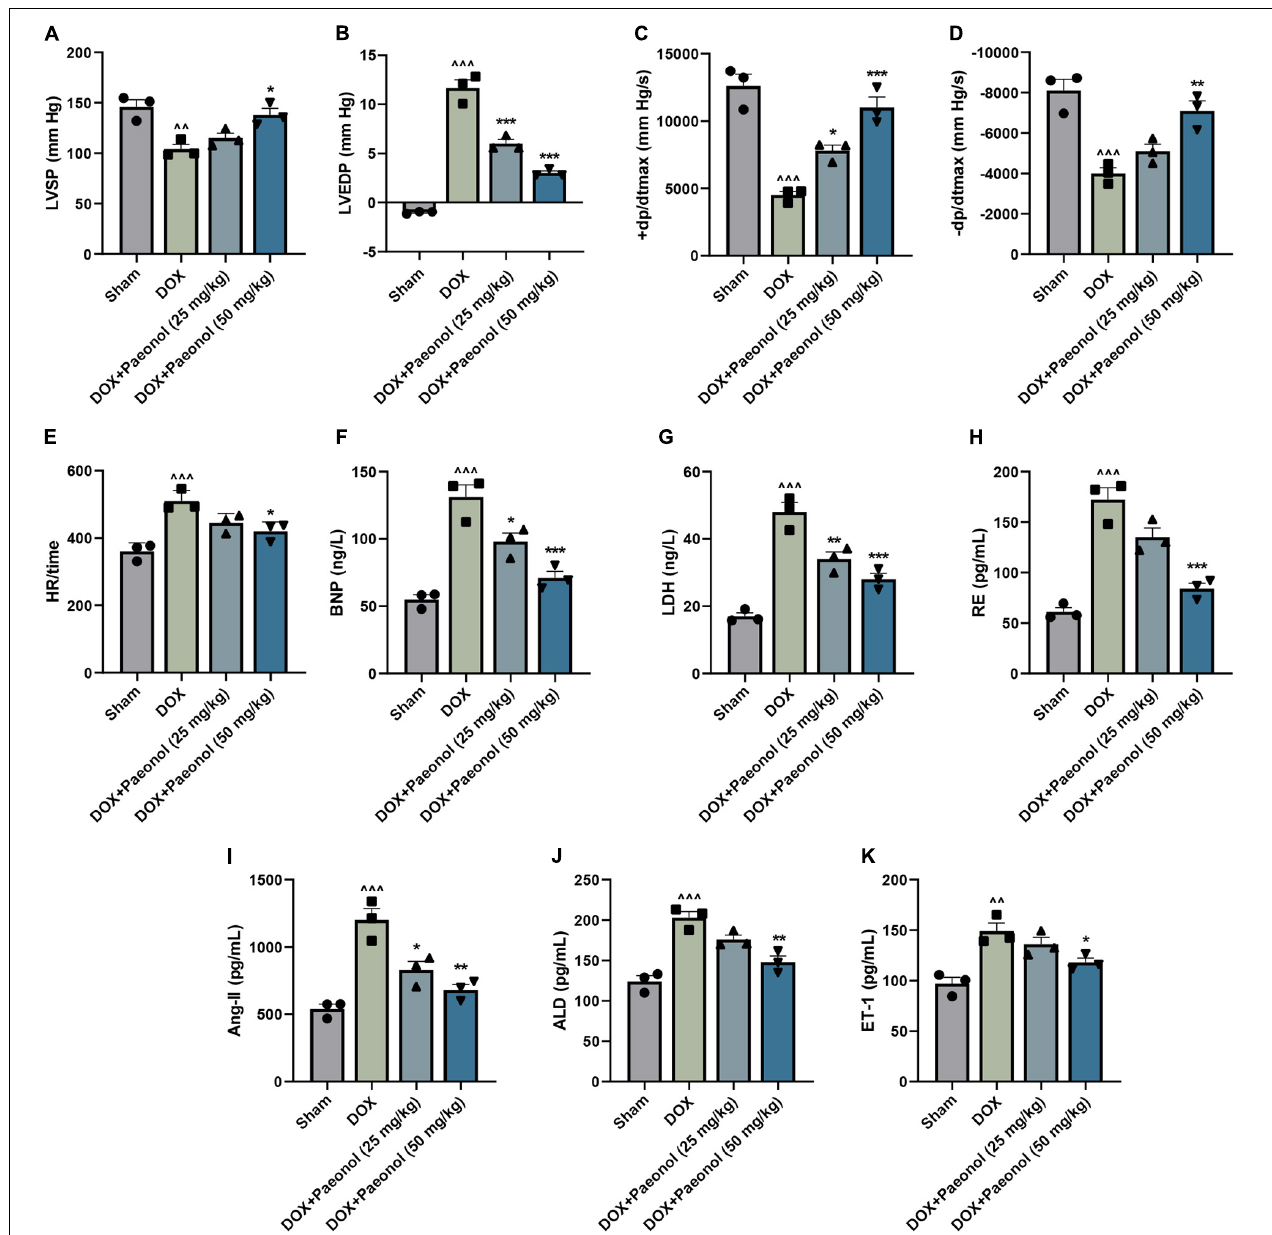
FIGURE 1 | Paeonol improved the cardiac function and ameliorated the cardiac damage of CHF rats. (A–E) The parameters underlying the cardiac function of the rats, including LVSP (A) , LVEDP (B) , +dp/dtmax (C) , –dp/dtmax (D) , and HR (E) , were detected using RM6240 series multichannel physiological signal acquisition apparatus. (F–K) The concentration of several specific markers related to the myocardial damage in the rats, including BNP (F) , LDH (G) , RE (H) , Ang II (I) , ALD (J) , and ET-1 (K) , were evaluated using a Synergy H1 Hybrid Multi-Mode Reader. ∧∧ P < 0.01, ∧∧∧ P < 0.001, vs. Sham; * P < 0.05, ** P < 0.01, *** P < 0.001, vs. DOX. DOX, doxorubicin; LVSP, left ventricular systolic pressure; LVEDP, left ventricle end diastolic pressure; +dp/dtmax, +left ventricle dp/dtmax; –dp/dtmax, –left ventricle dp/dtmax; HR, heart rate; BNP, brain natriuretic peptide; LDH, lactate dehydrogenase; RE, renin; Ang II, angiotensin II; ALD, aldosterone; ET-1, endothelin